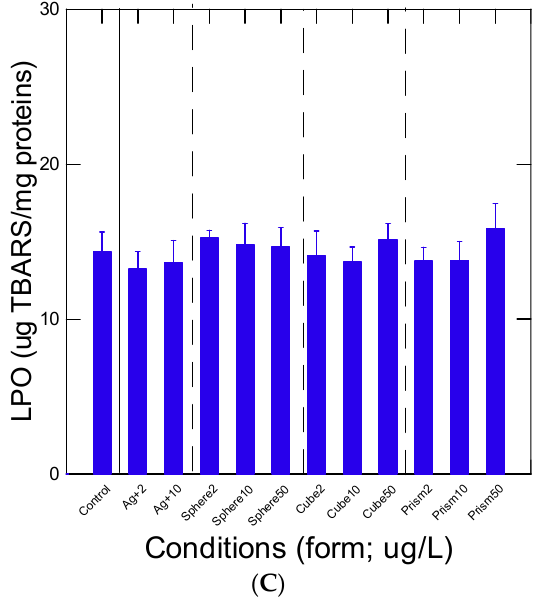
Figure 3. Oxidative stress in mussels exposed to various nAg forms. Mussel tissue homogenates were prepared for viscosity ( A ), arachidonate cyclooxygenase activity ( B ) and lipid peroxidation ( C ). The data represent the mean with the standard error. The star symbol * indicates significance from controls.